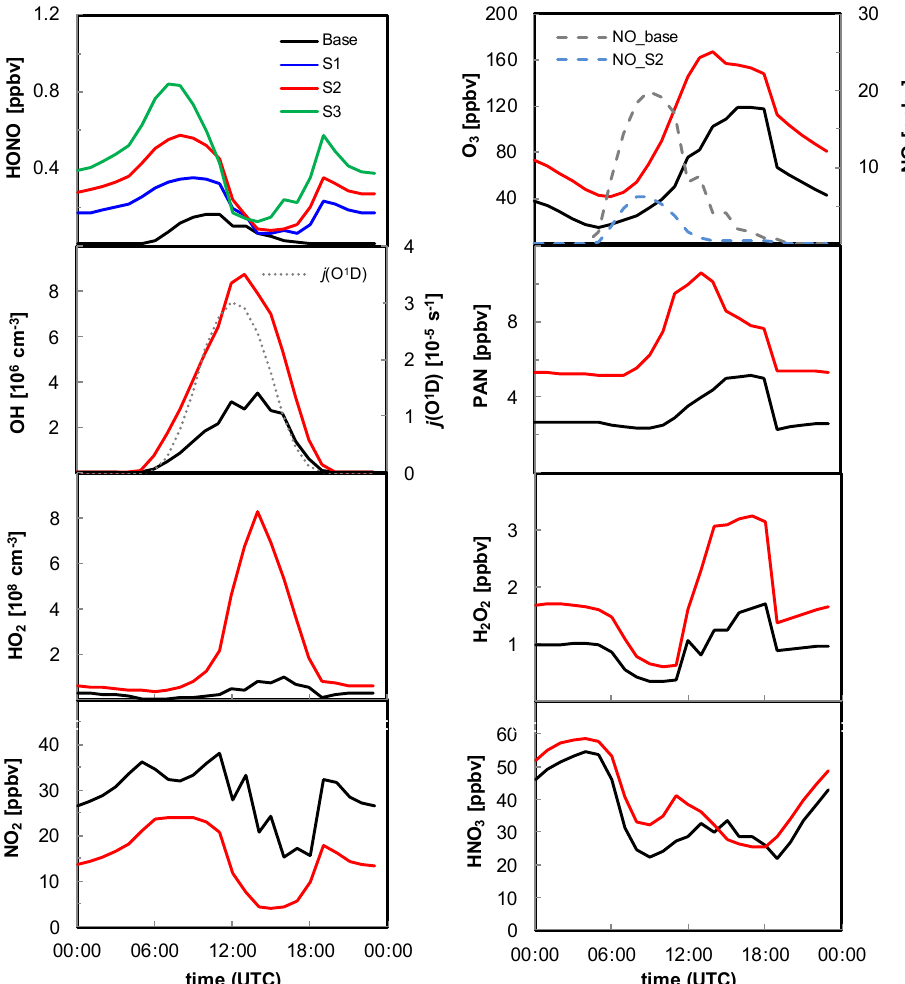
Fig. 14. Simulated diurnal cycles in the eastern USA (40.5 ◦ N, 73.1 ◦ W) on 1 June Figure 14: Simulated diurnal cycles in the eastern USA (40.5°N, 73.1°W) on June 1, 2005.